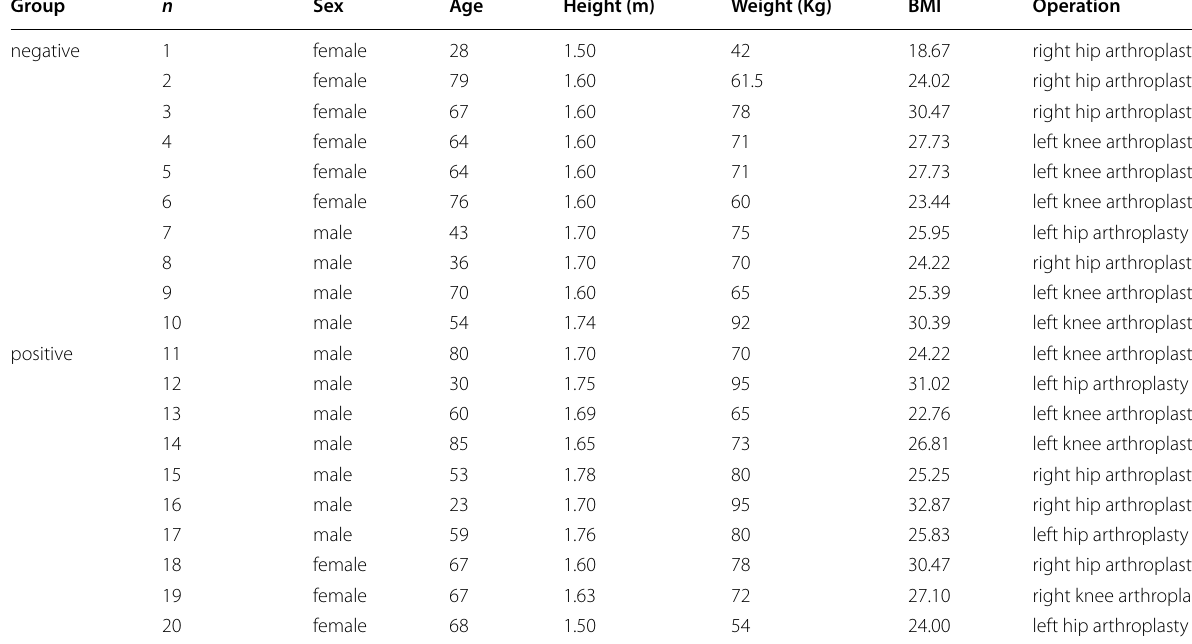
Table 4 Basic data of the